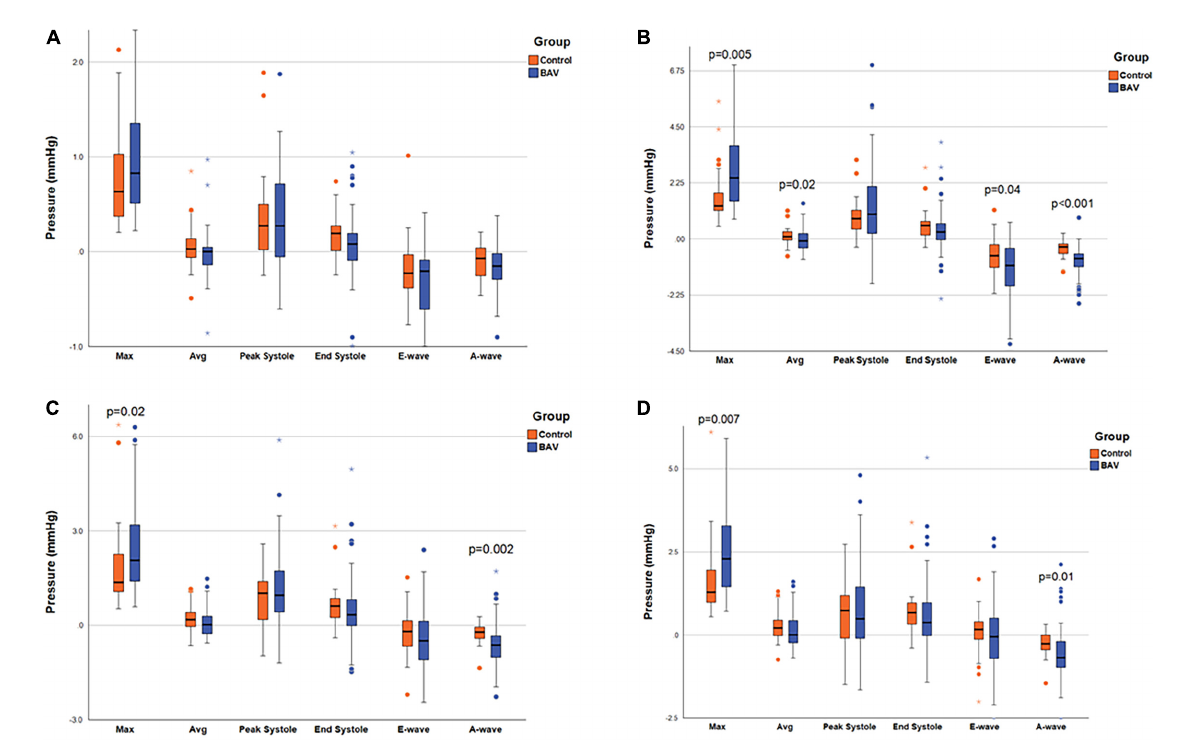
FIGURE3 Ventricular pressure measurements. The box plot at the locations of (A) LA middle part, (B) MV, (C) LV middle part, and (D) LV apex, pointing out the significant pressure differences between the two groups. Left atrium (LA), mitral valve (MV), and left ventricle (LV). Circles are the outliers and asterisks ( ∗ ) are the extreme outliers.